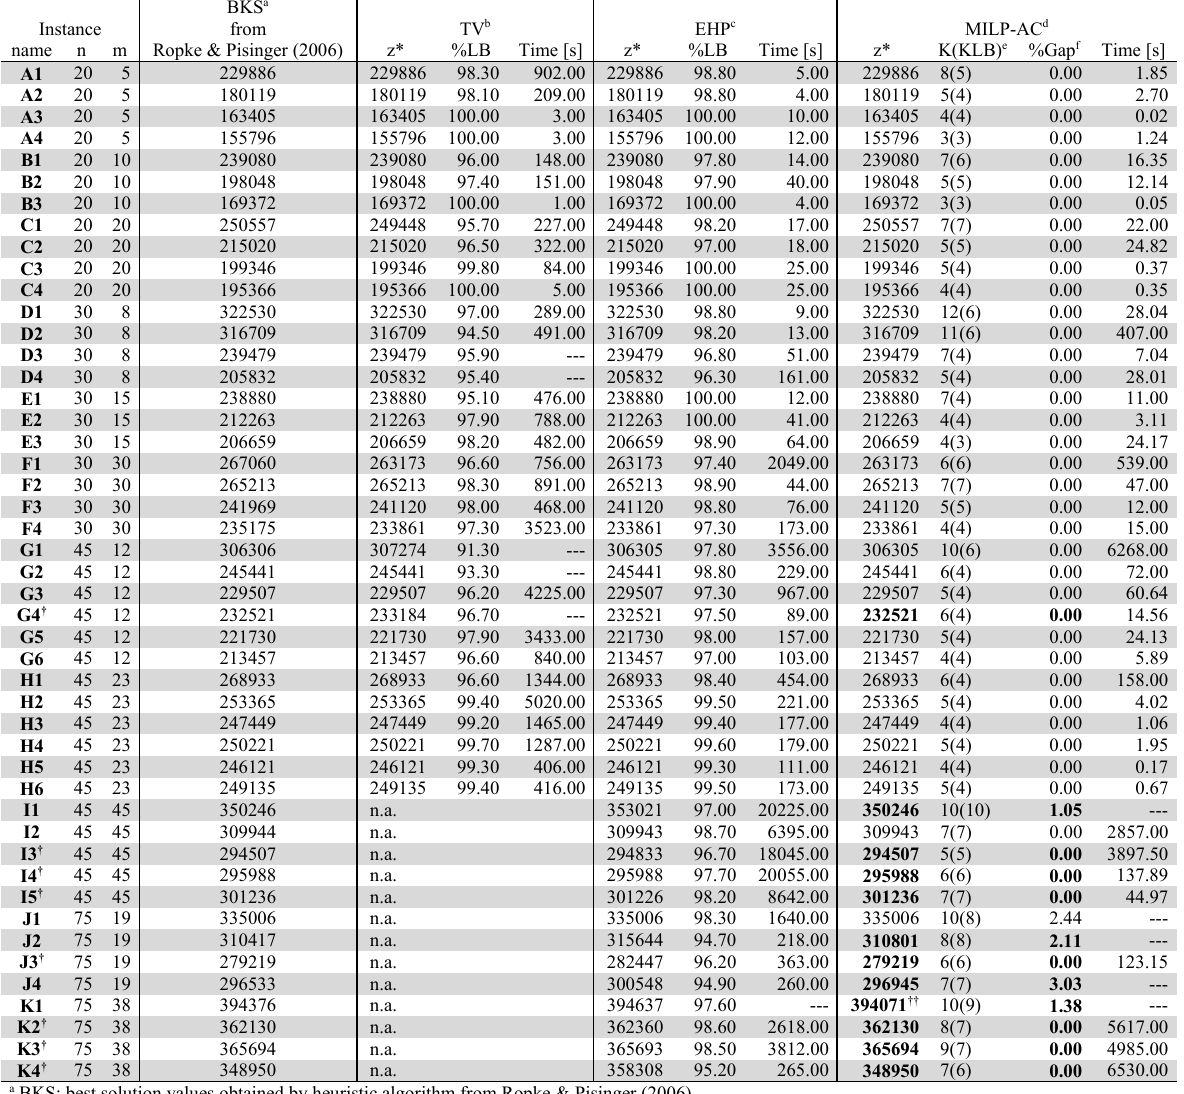
Computational results for the VRPB cases from Goetschalckx and Jacobs-Blecha (1989),